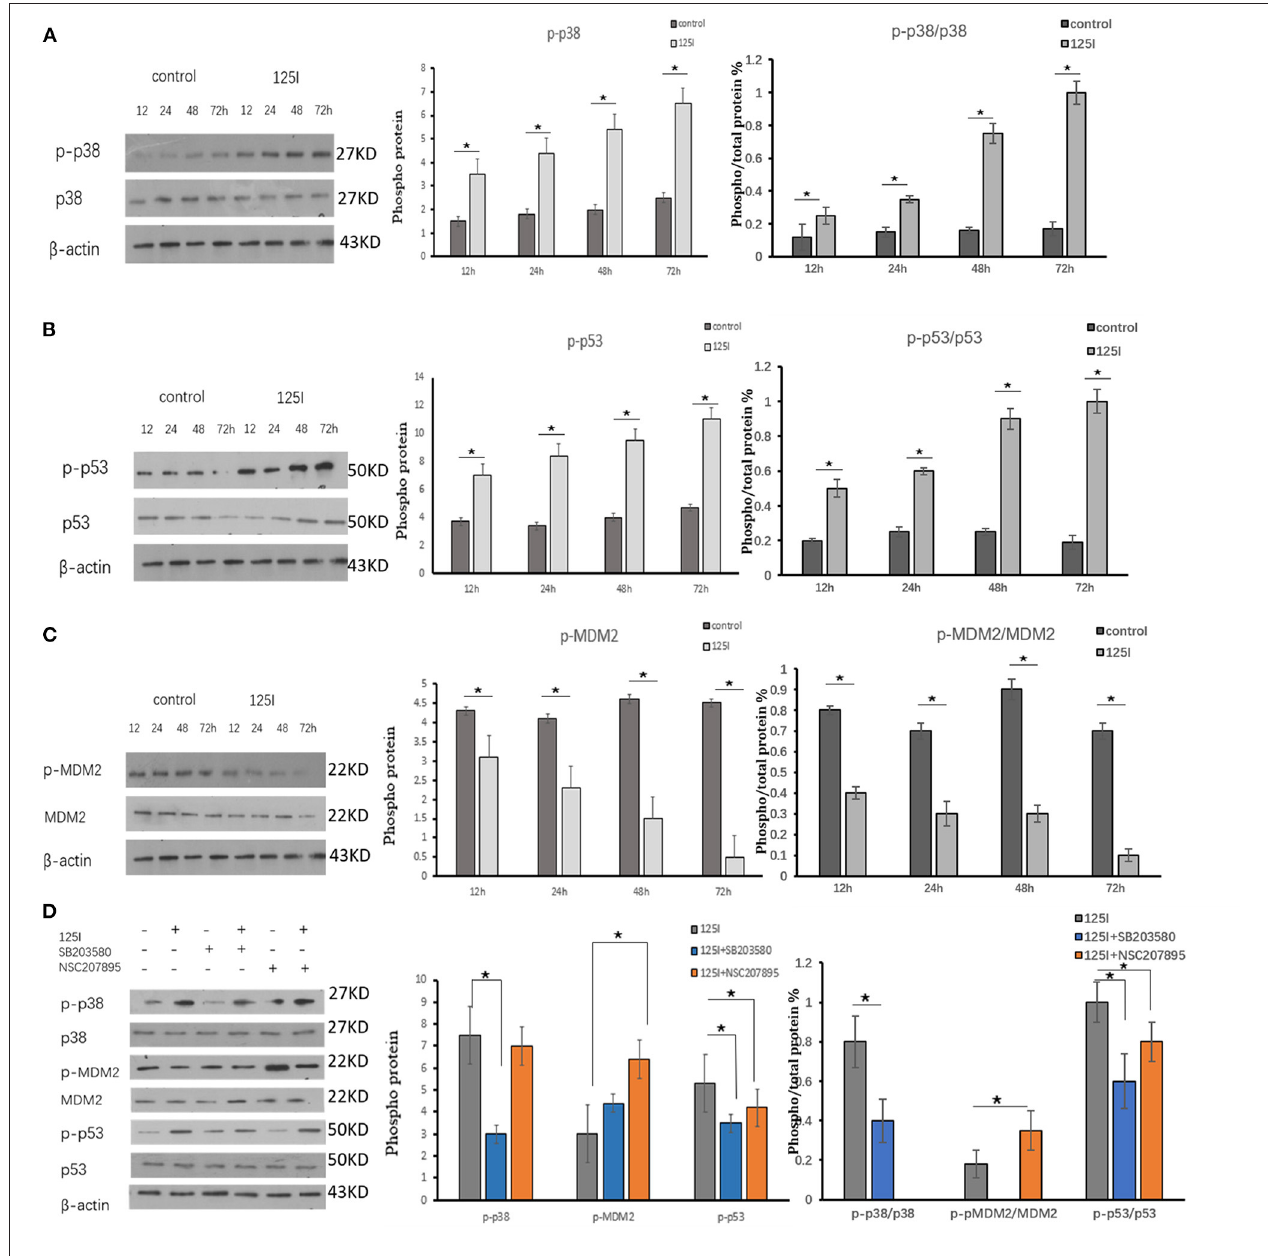
FIGURE 3 | (A–C) A549 cells were irradiated in six-well plates for 12, 24, 48, and 72h. Compared with the control group, the intracellular phosphorylation levels of p38 and p53 increased gradually over time in the 125 I seed group, and MDM2 was reduced over time. P38, p53, and MDM2 total protein expression was not different between the two groups. The ratio of phosphorylated p38 and p53 protein to total protein increased over time, and it decreased MDM2. The data are presented as the means ± SD. (D) The expression of p-p38, p-pMDM2, and p-p53 and their total proteins were analyzed using Western blot analysis. After irradiation by 125 I seed, p-p38 and p-p53 expression levels increased and p-MDM2 expression level decreased. The p38 inhibitor (SB203580) suppressed the expression level of p-p38, increased the expression levels of p-MDM2, and decreased the expression levels of p-p53. The level of p38, MDM2, and p53 showed no obvious changes. The data are represented as the means ± SD of three independent experiments. There was statistical significance between the control and treated groups, * P < 0.05.